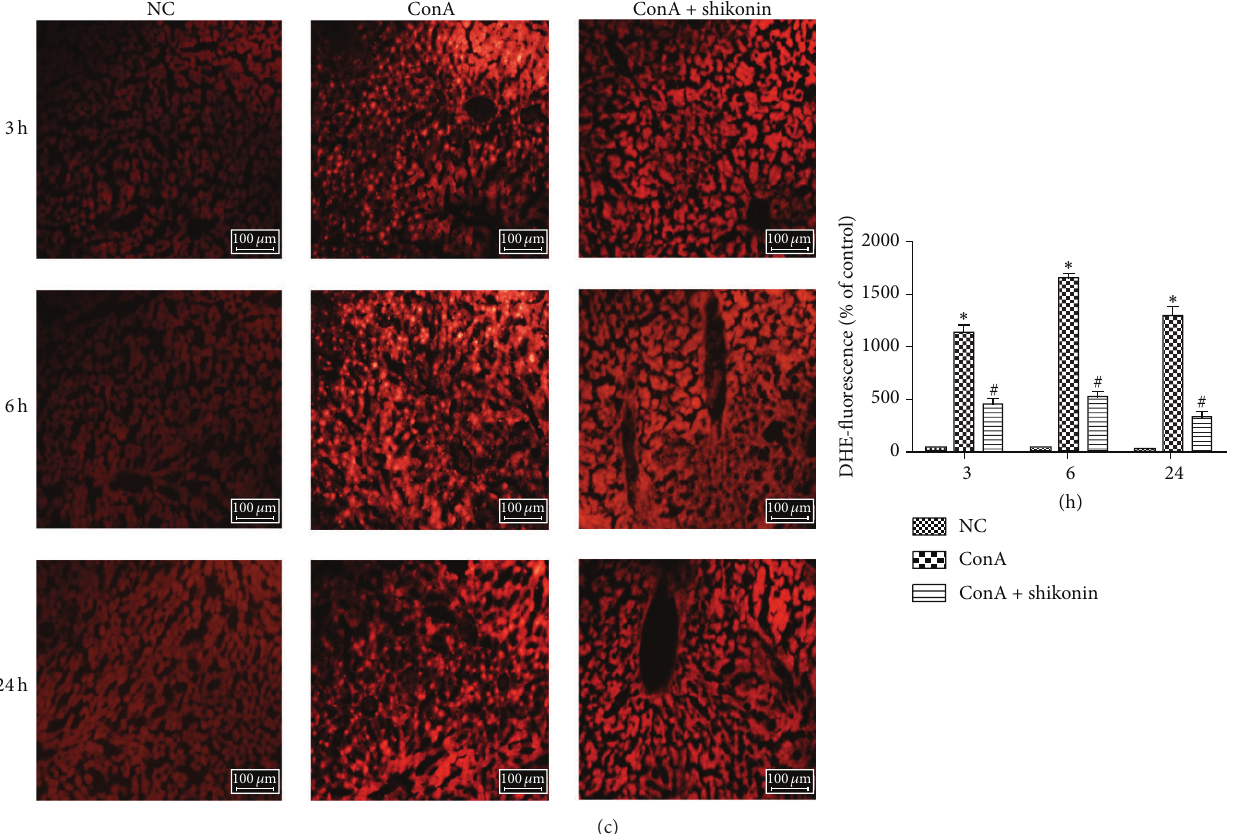
Figure 5: Effects of shikonin on the regulation of the IL-1 𝛽 /JNK/p-JNK pathway in mice with ConA-induced acute hepatitis. (a) The levels of proteins IL-1 𝛽 , total JNK, and p-JNK in liver tissue are shown as western blot bands and the gray values were calculated ( 𝑛 = 8 , ∗ 𝑃 < 0.05 for NC versus ConA, # 𝑃 < 0.05 for ConA + shikonin (7.5) versus ConA, and + 𝑃 < 0.05 for ConA + shikonin (12.5) versus ConA). (b) The expression of p-JNK in hepatic tissues was determined with immunohistochemistry at 6h (original magnification, × 200). The ratio of brown area to total area was analyzed with Image-Pro Plus (v 6.0) ( 𝑛 = 8 , ∗ 𝑃 < 0.05 for NC versus ConA and # 𝑃 < 0.05 for ConA versus ConA + shikonin). (c) The generation of ROS was detected with ROS Fluorescent Probe-DHE. And ROS were measured and analyzed in three random vision fields by Image-Pro Plus 6.0 ( 𝑛 = 8 , ∗ 𝑃 < 0.05 for NC versus ConA and # 𝑃 < 0.05 for ConA + shikonin versus